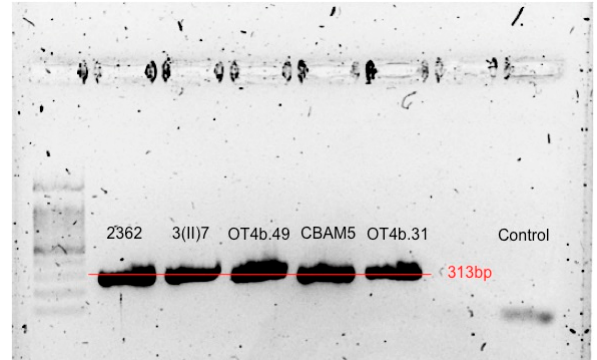
Figure 5. Putative amoA amplification for the L. sphaericus strains used in this study .